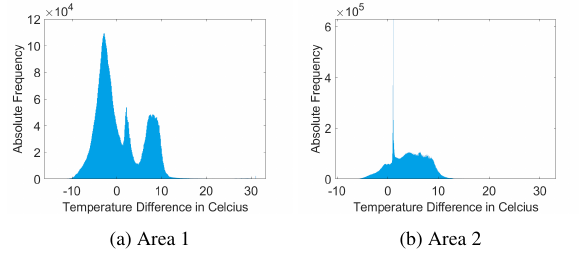
Figure 4. Temperature Difference Distributions